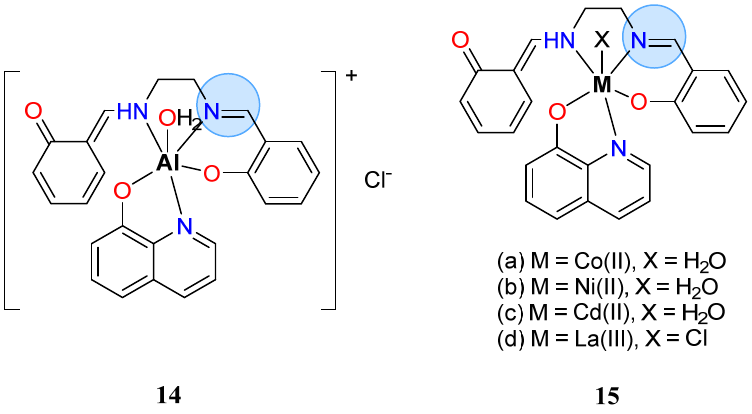
Figure 8. Salen ‐ metal complexes with antibacterial and antifungal activity. Figure 8. Salen-metal complexes with antibacterial and antifungal